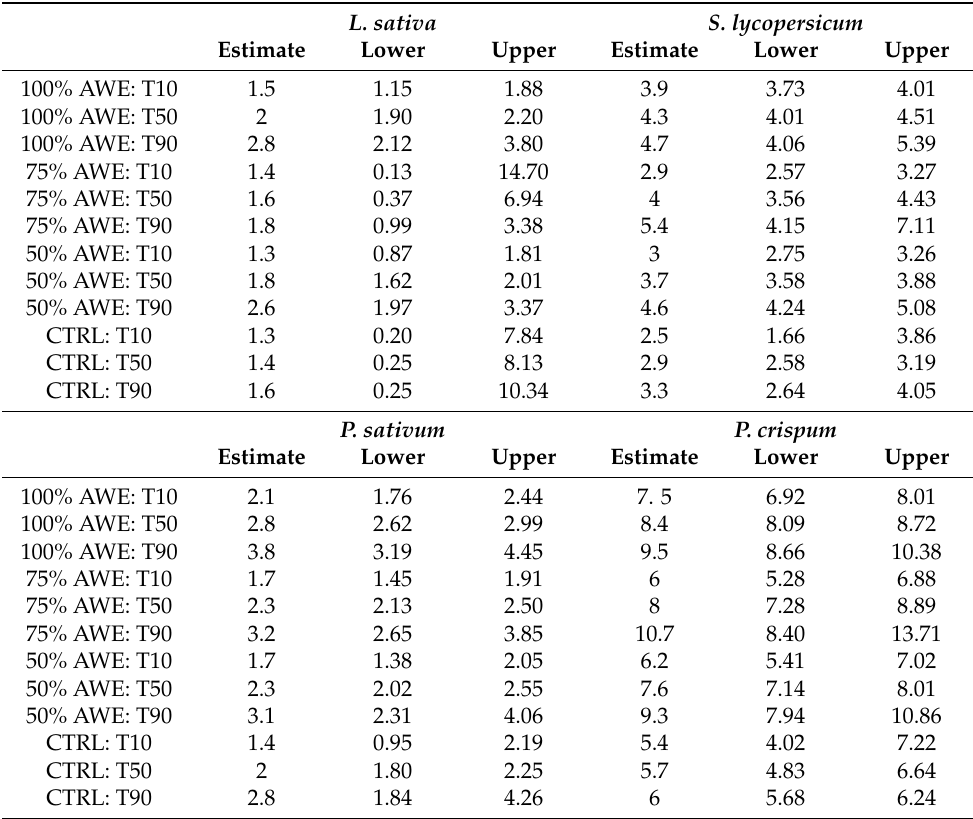
Table 5. Estimated times of germination (10-percentile (T10), median (T50) and 90-percentile (T90)) and their bounds (Lower-Upper) for Lactuca sativa L., Solanum lycopersicum L., Pisum sativum L., Petroselinum crispum (Mill.) under AWE treatments (50% AWE, 75% AWE, 100% AWE) and control